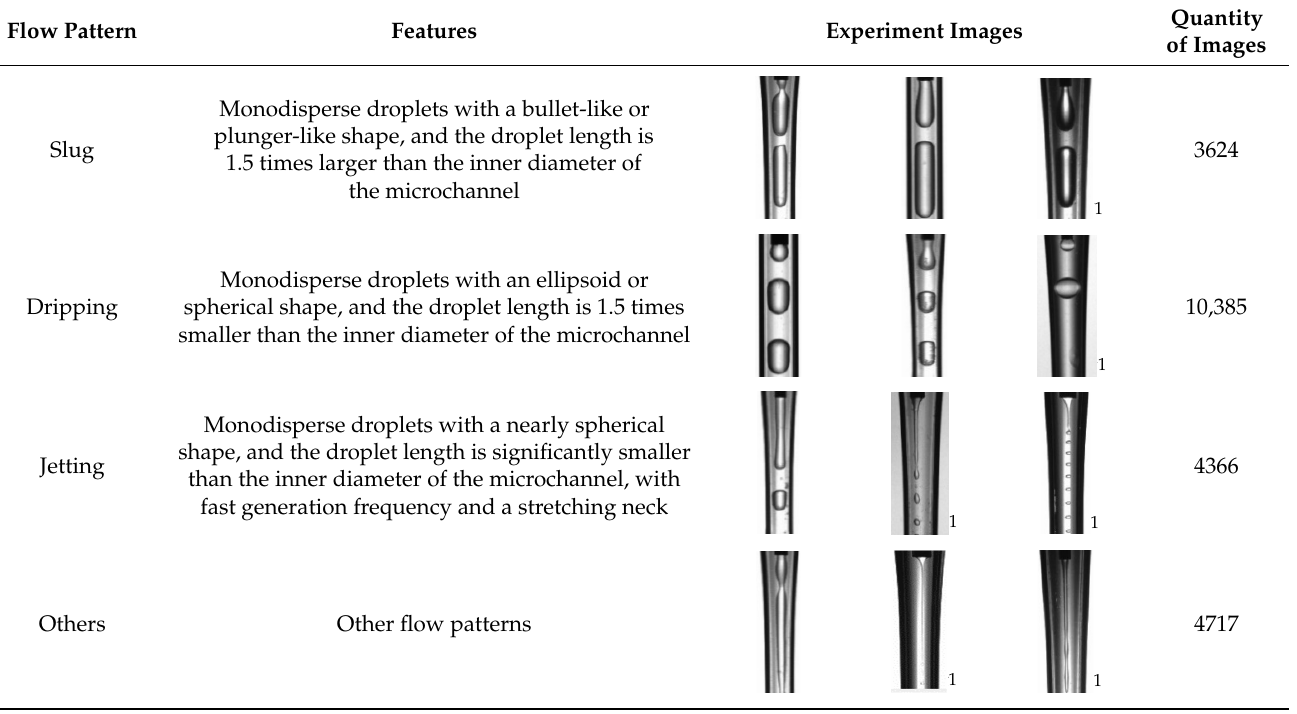
Table 2. The definition of flow patterns with different images.